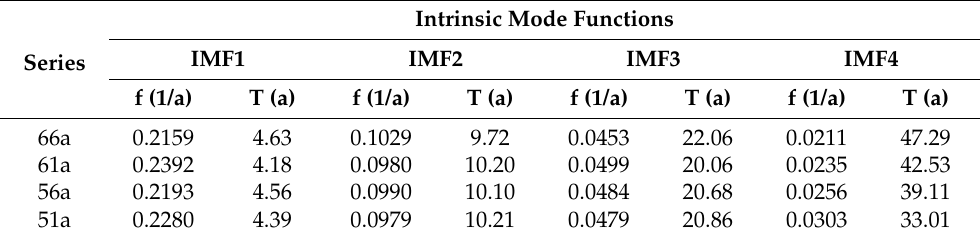
Table 4. The center frequencies and average periods of IMFs from annual series at Lijin station.